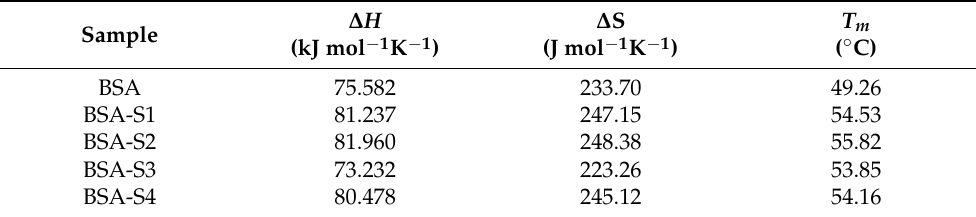
Figure 7. ( A ) BSA (3 µ M) denaturation by temperature in the presence of the ferrihydrite nanoparticles (3 µ M). ( B ) Graphical representation of ln K eq vs temperature, corresponding to the BSA ( • ), BSA-S1 ( • ), BSA-S2 ( (cid:4) ), BSA-S3 ( (cid:78) ), and BSA-S4 ( (cid:72) ) samples. Table 6. Thermodynamic fingerprint of BSA denaturation in the presence of biogenic ferrihydrite